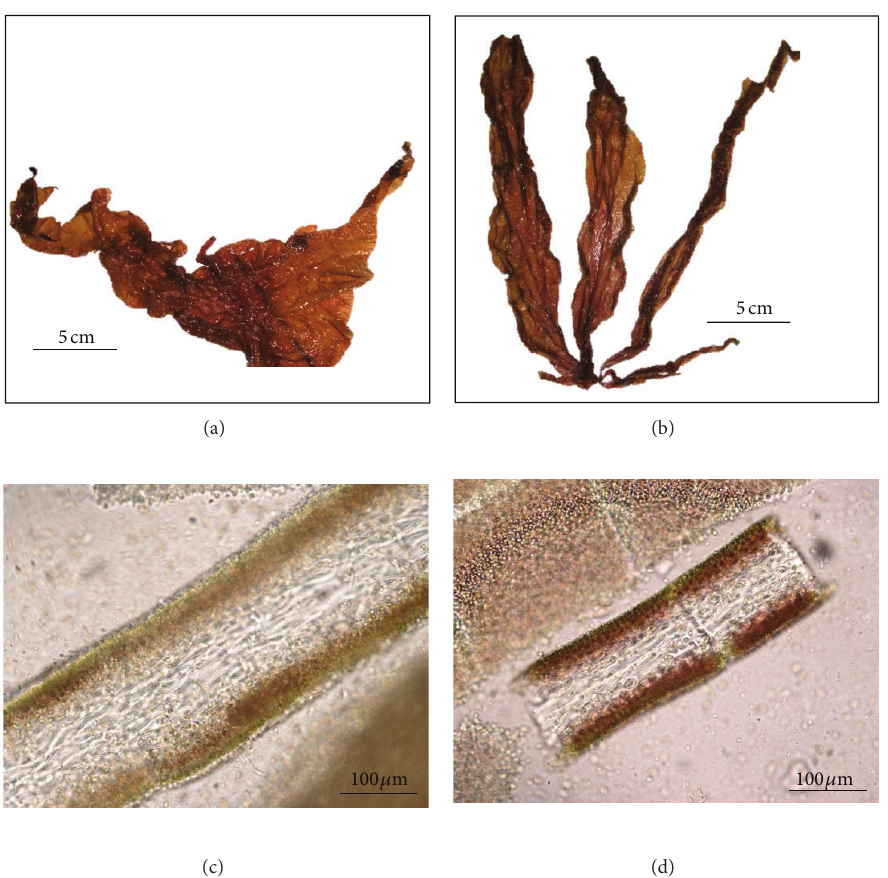
Figure 3: Grateloupia turuturu thalli collected from two different sites: A and B. (a) Morphological observation of thallus from A. (b) Morphological observation of thallus from B. (c) Transversal section of A thallus. (d) Transversal section of B